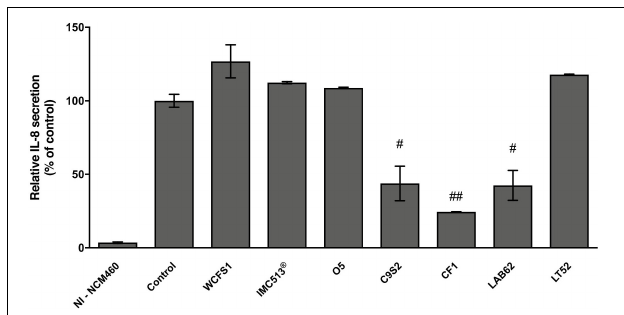
FIGURE 8 | Lactobacillus plantarum modulation of IL-8 release on inflamed NCM460 cells. Values are expressed as mean ± SEM. ## p < 0.005 and # p < 0.05 versus inflamed